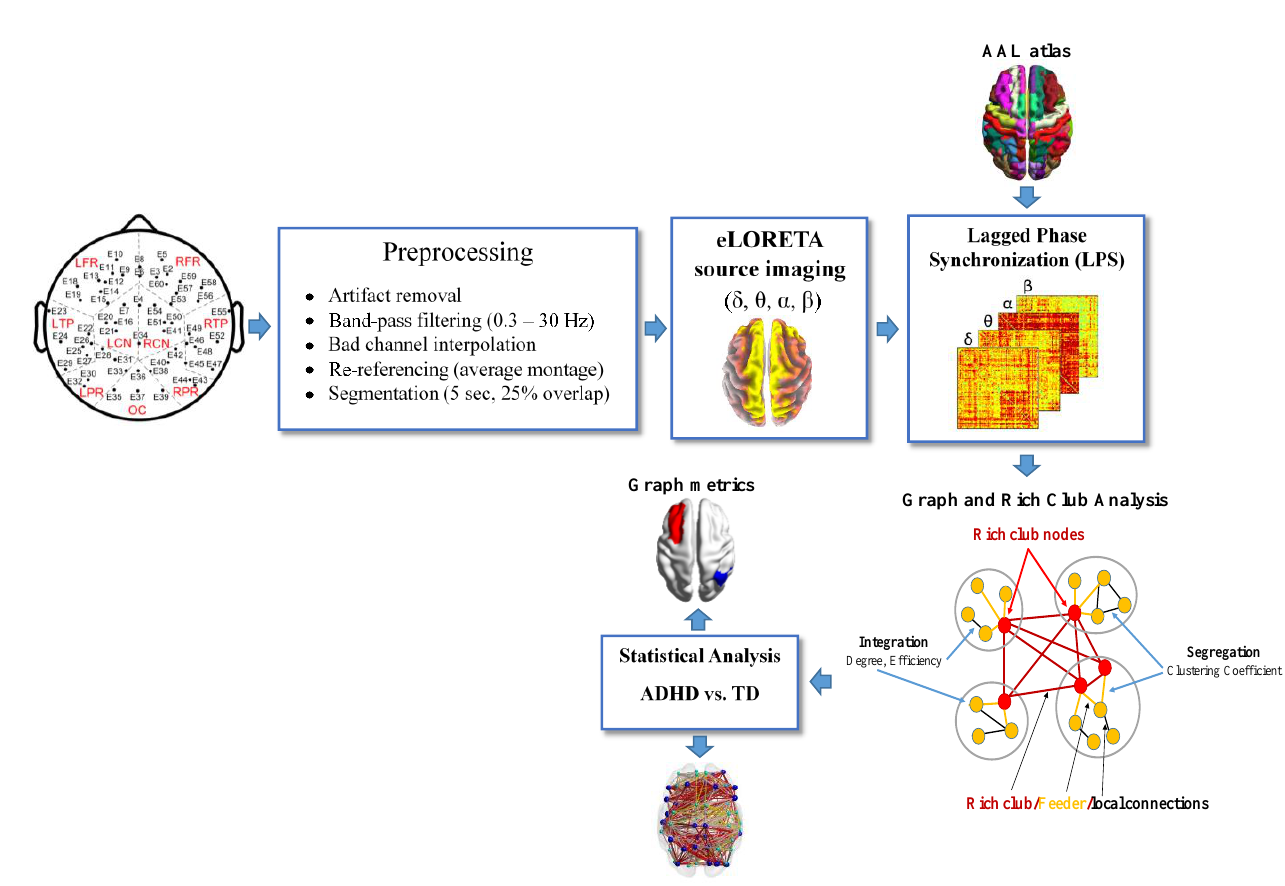
Figure 1. Processing pipeline, including preprocessing, source analysis, connectivity and graph analyses using high-density EEG in the source space.